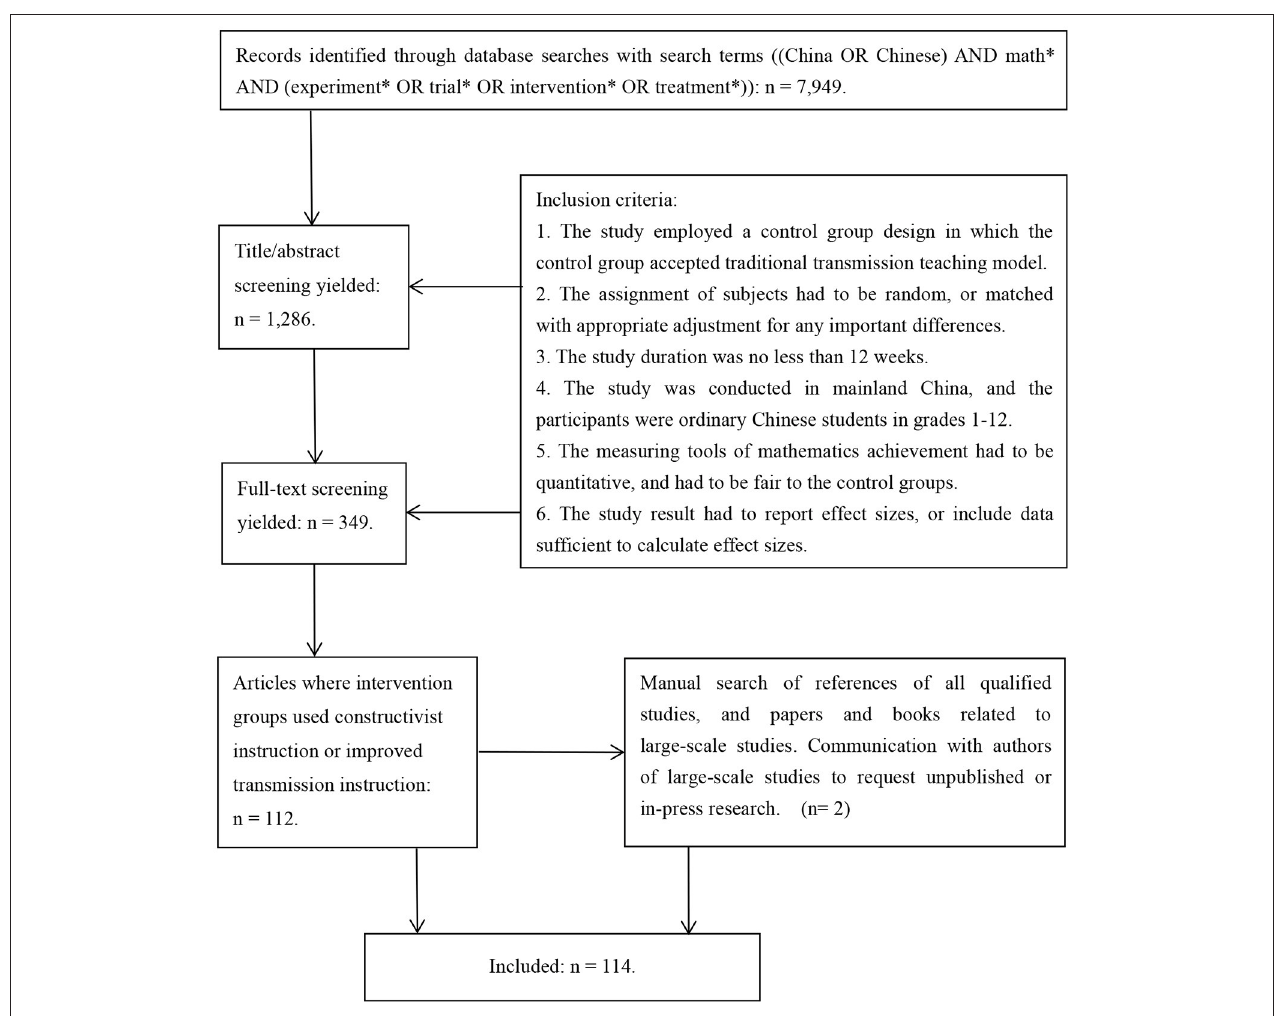
FIGURE 1 | The follow chart of study